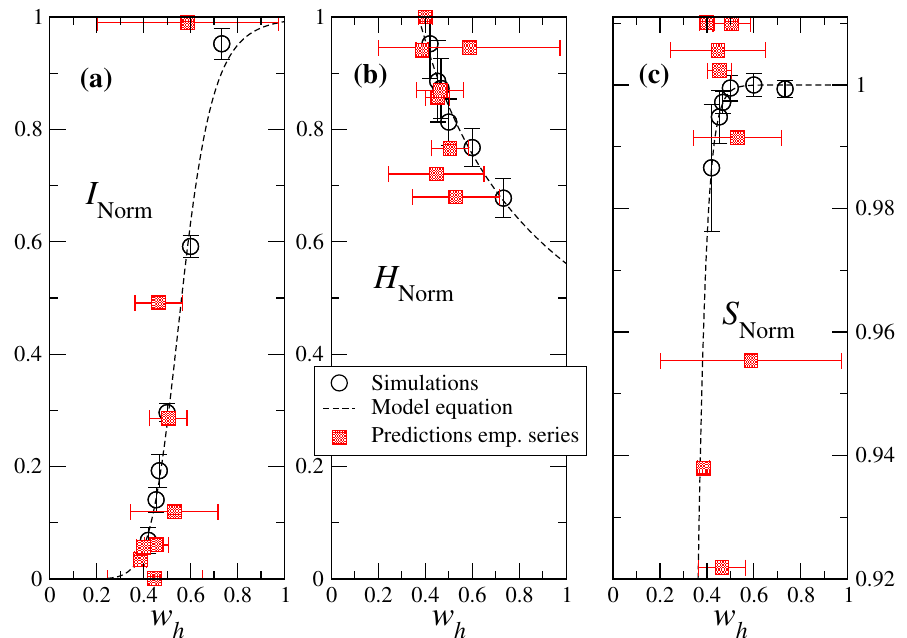
Figure 6. Repeating Figure 5 with the effective gametocytemia for each empirical series (see